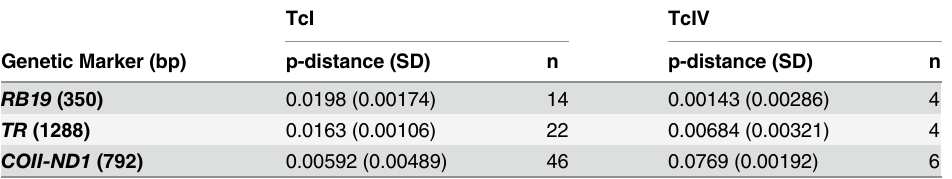
Table 3. Mean uncorrected pairwise-distances for Esc26. Each p-distance represents the average pro- portion of nonidentical nucleotide positions between Esc26 and the TcI and TcIV T . cruzi sequences used to generate the RNA-binding protein-19 ( RB19 ), trypanothione reductase ( TR ) and cytochrome oxidase II-NADH 1 ( COII-ND1 ) phylogenetic trees. The number of nucleotide positions (bp) for each gene is indicated, as is the number of comparison sequences (n) evaluated within each